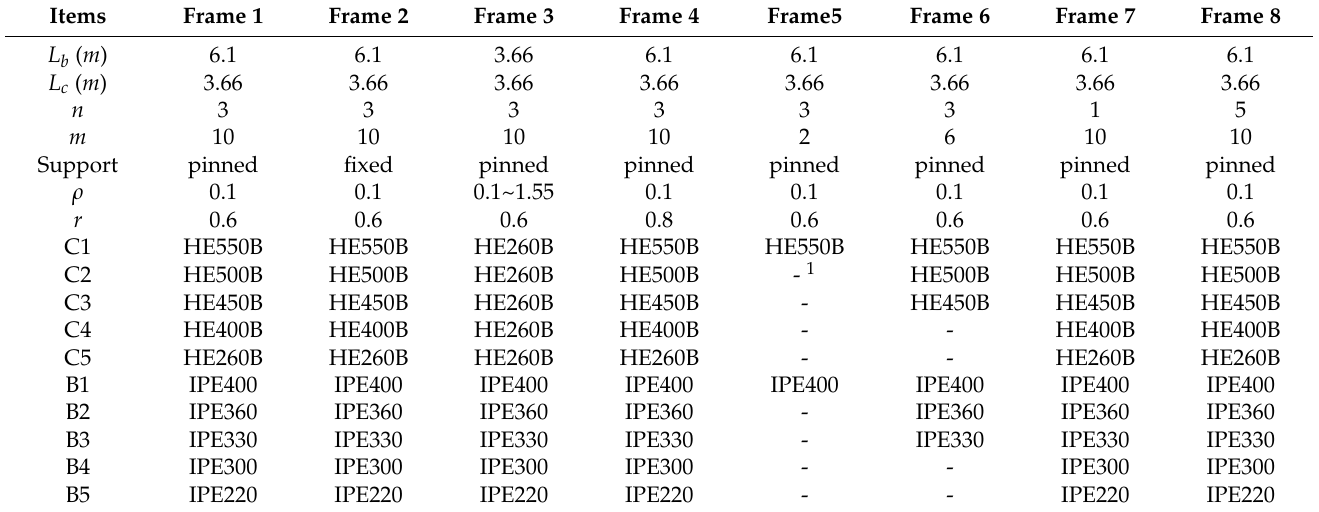
Table 1. Information for structural models.